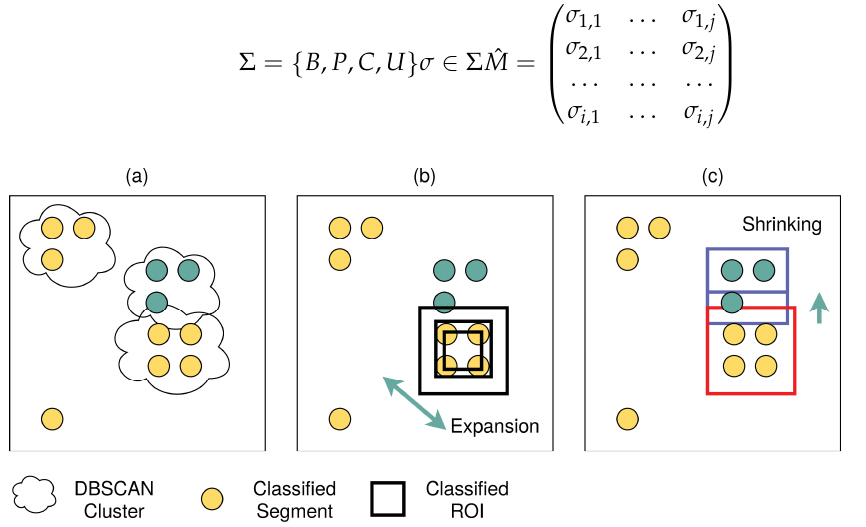
Figure 4. ( a ) DBSCAN Clustering ( b ) Iterative bounding box expansion ( c ) final overlapping conflict shrinking.